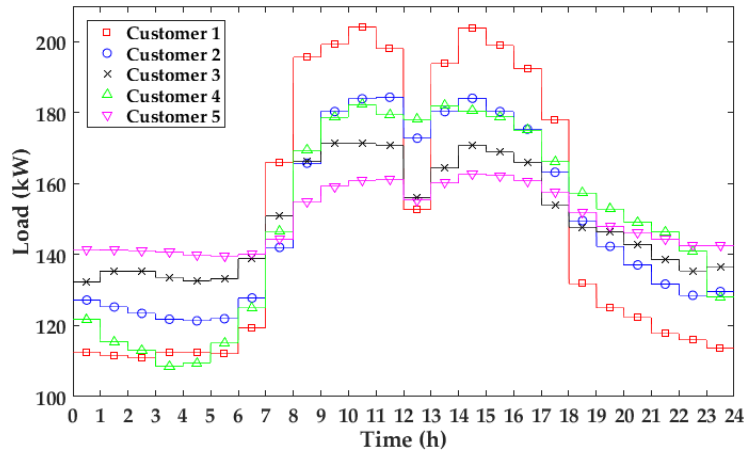
Figure 7. Load demand profile.